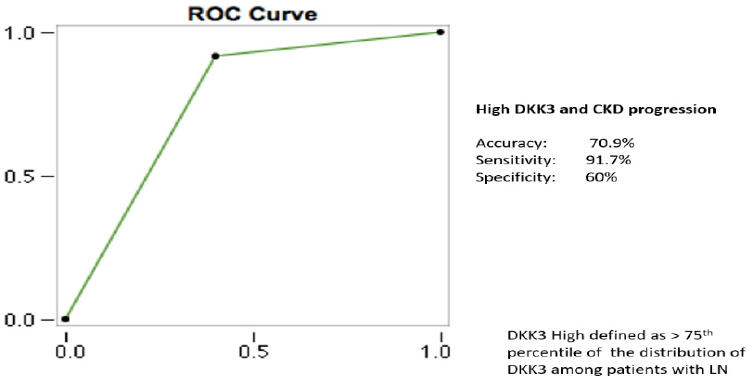
Figure 3. CKD progression as outcome. Characteristics of the ROC curve for the employed DKK3 cut-off. (ROC = receiver operating characteristic; DKK3 = Dickkopf-related protein 3; CKD = chronic kidney disease).